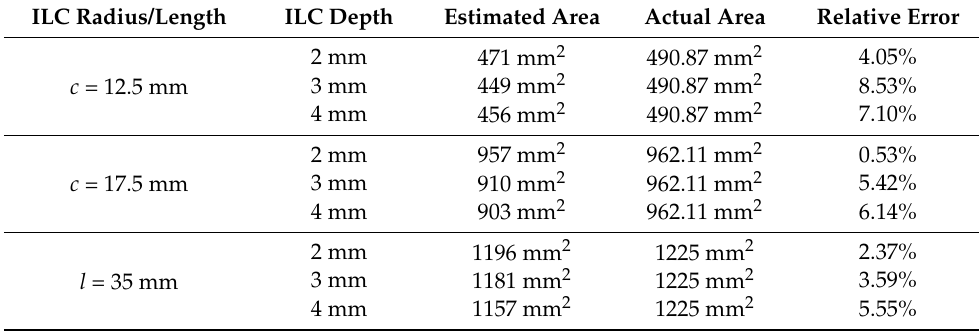
Figure 11. Edge-identification results for ILC Scenario #2. Table 3. Assessment results regarding ILC opening areas for ILC Scenario #1.